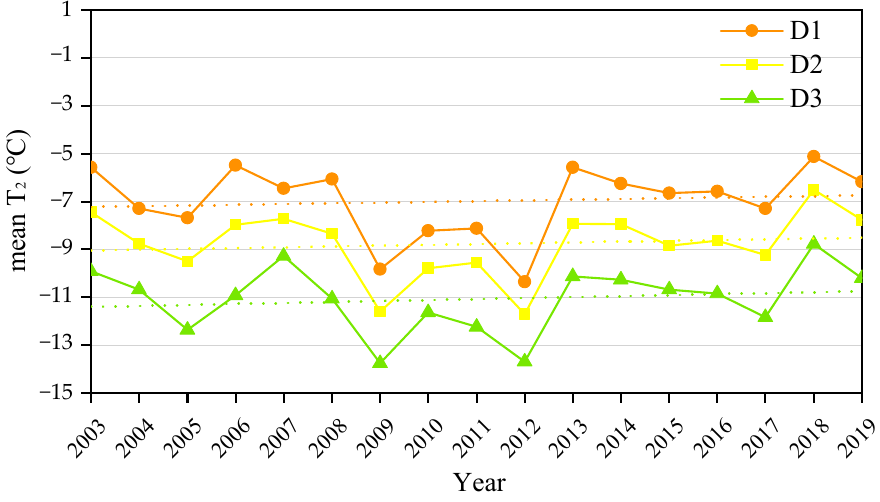
Figure 3. The air temperature (T 2 ) changes during the central heating seasons. The changes in the daily land surface temperature are observed in Figure 4. It can be seen that the LST of the urban areas was higher than the suburbs. The polygon of the urban extent was extracted from Google Earth images and the datasets of global annual urban extents [74]. There are apparent urban heat islands at night, and the urban heat island area in the hot region increased by 9.1% for D1, 19.6% for D2, and 47.7% for D3, according to the mean standard deviation method [61]. Since the urban heat island area has expanded, it is inferred that human activities induce change.